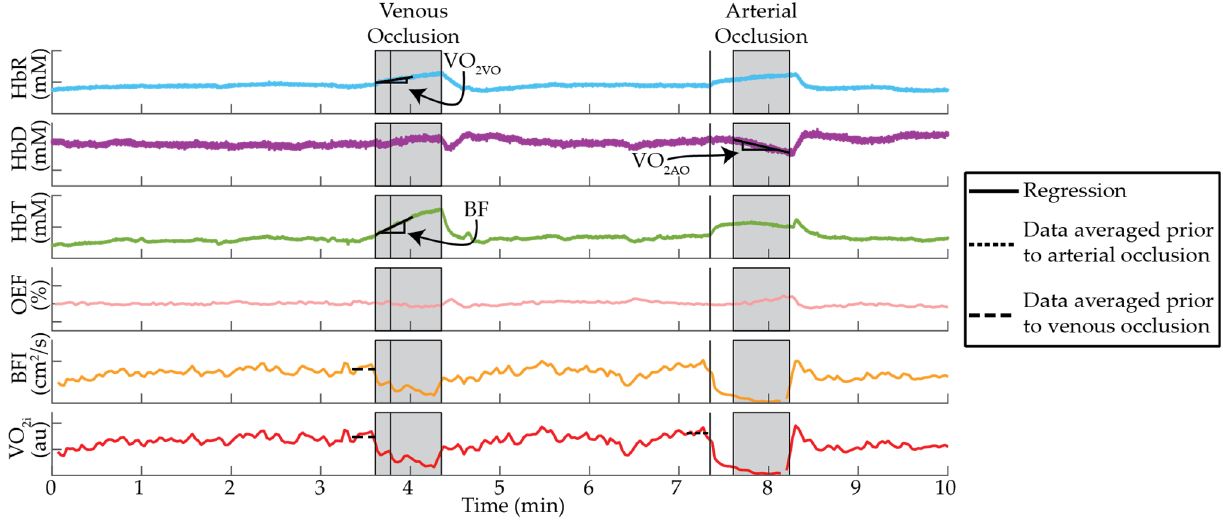
Figure 6. Representative cuff occlusion data. NIRS-measured deoxyhemoglobin (HbR), hemoglobin difference (HbD), total hemoglobin (HbT), and oxygen extraction fraction (OEF), along with DCS-measured blood flow index (BFI), and NIRS/DCS measured oxygen metabolism index (VO 2i , in units of cm 2 /s*mLO 2 /g) as a function of time during a single occlusion epoch. Shaded regions indicate the venous and arterial occlusions; vertical black lines denote the start of cuff occlusion, the time point when the cuff pressure reached the desired target, and the cuff release. Solid black lines indicate the linear regressions used to quantify NIRS-only measures of blood flow and oxygen metabolism. Dotted lines indicate regions of BFI and VO 2i that were averaged for comparison with NIRS-only measures.